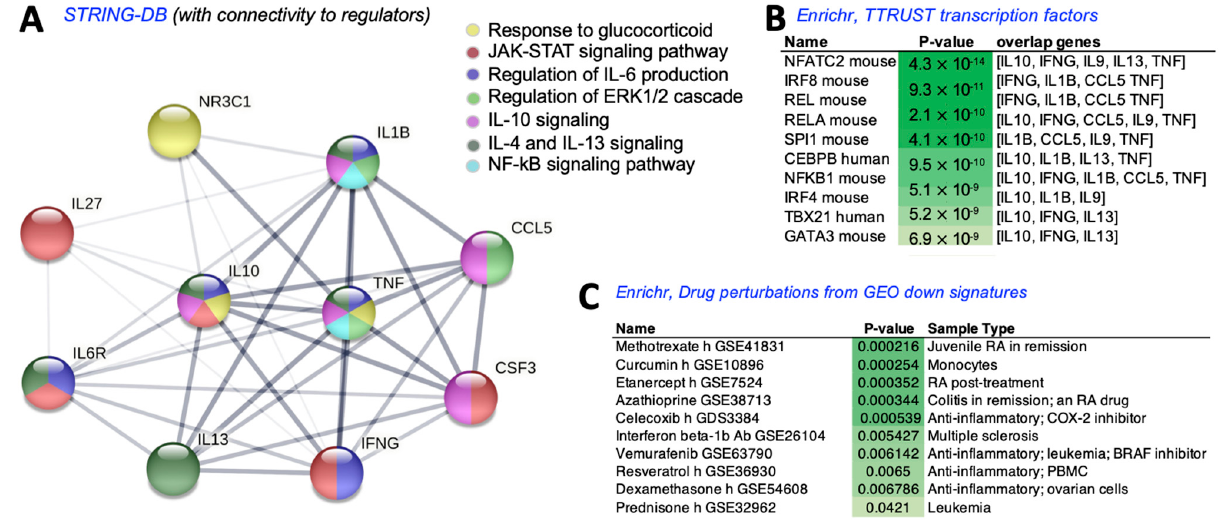
Figure 8. Pathway analysis of the cytokine networks impacted by P + pORF-27pL. ( A ) Protein–protein interaction network from STRING-DB to visualize connections between pathways differentially modulated by P + 27pL relative to monotherapies; ( B ) Enrichr analysis using a TTRUST transcription factors database, and ( C ) Enrichr analysis using the signatures from drug perturbations from GEO down dataset.